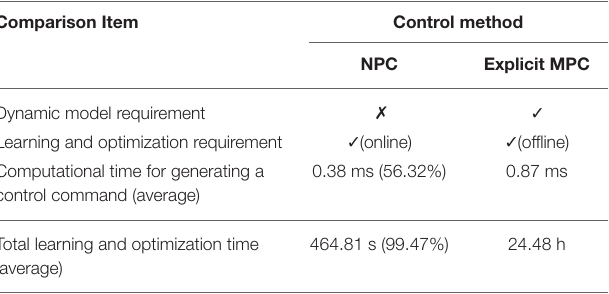
TABLE 1 | Comparison table showing the difference between implementing the NPC and the explicit MPC as the main controller of the simulated UAV speed adaptation